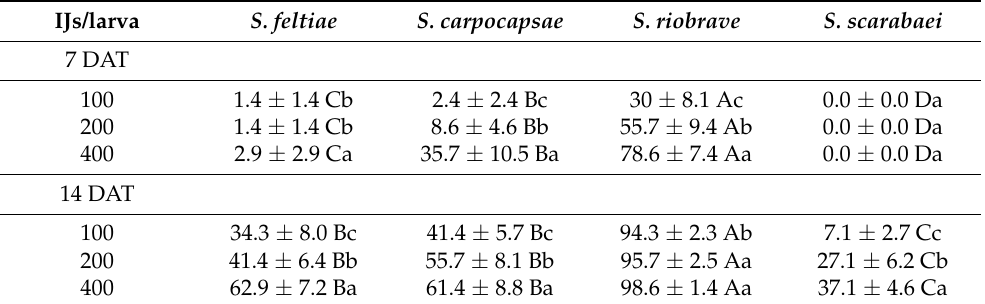
Figure 2. Persistence of the entomopathogenic nematodes Heterorhabditis bacteriophora (Hb), Steinernema carpocapsae (Sc), S. riobrave (Sr), and S. feltiae (Sf) in cups with 100 g of moist sandy loam ( top ) and blueberry soil ( bottom ). Persistence was determined by saturation baiting with waxworms, the larvae of the greater wax moth. Letters next to symbols indicate significant differences in the total number of waxworms infected among baiting dates within species ( p < 0.05). 3.2. Virulence of EPNs to C. nenuphar Larvae Table 1. Percentage mortality ( ± SEM) of Conotrachelus nenuphar larvae exposed to three rates # of four entomopathogenic nematode species at 7 and 14 days after treatment